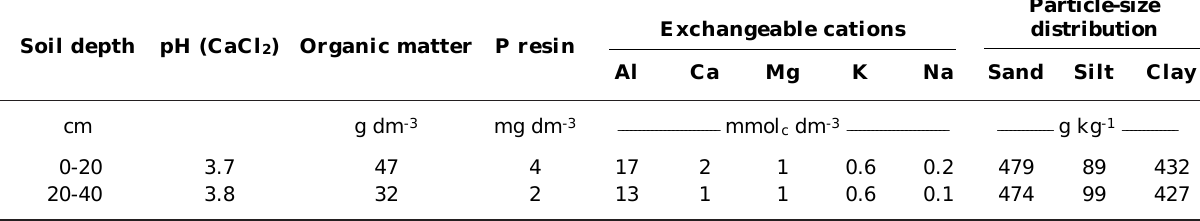
Particle-size Exchangeable cations